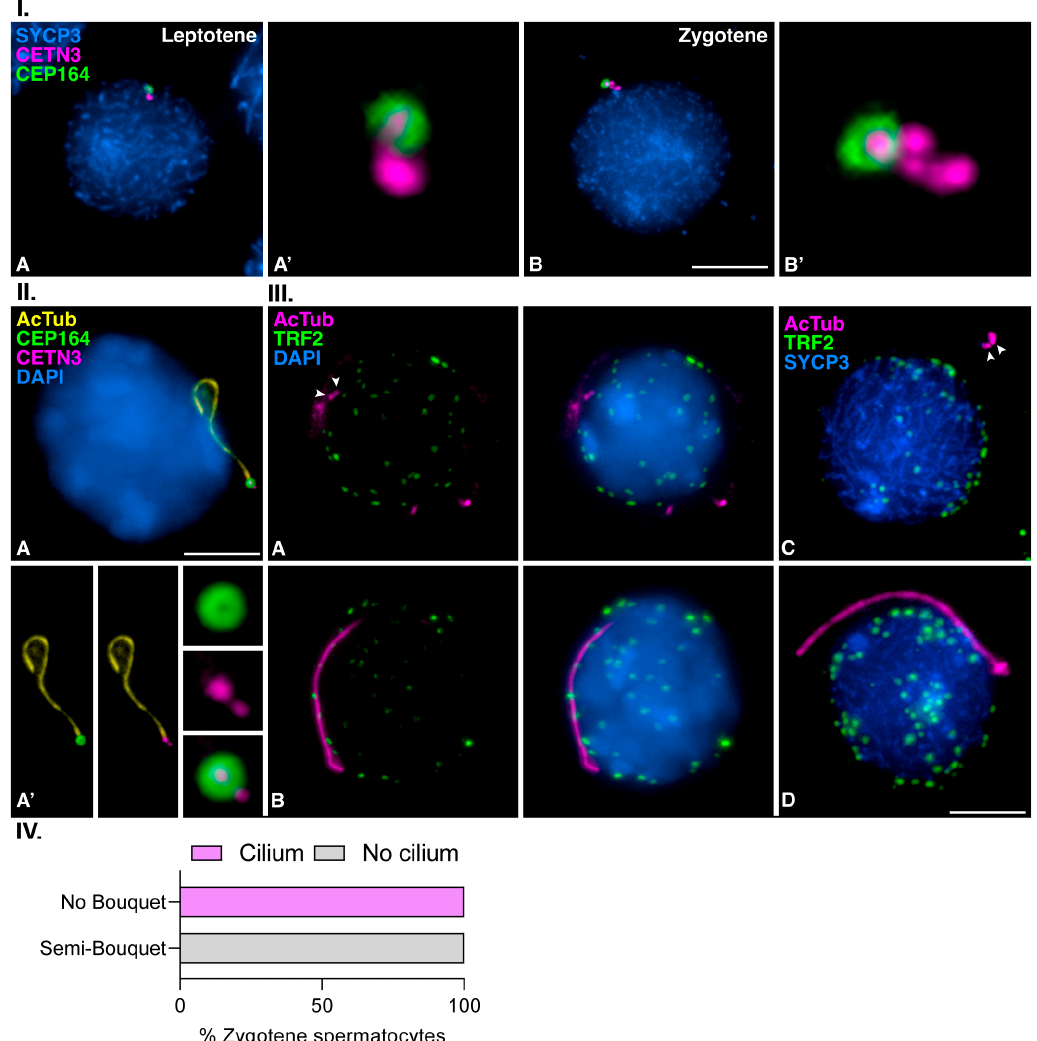
Figure 6. Mouse meiotic cilia emanate from the mother centriole before centrosome duplication. ( I ) . Distribution of CEP164 in early prophase I spermatocytes; Triple immunolabelling of SYCP3 (blue), Centrin 3 (CETN3) (magenta), and CEP164 (green) in mouse spermatocytes at ( A ) Leptotene, and ( B ) Zygotene. Images ( A (cid:48) , B (cid:48) ) show the 300 × magnification of the centrosomes. Scale bar in B represents 5 µ m. ( II ) . Meiotic zygotene cilia emanate from the unduplicated mother centriole; Triple immunolabelling of acetylated Tubulin (AcTub) (yellow), CEP164 (green), and Centrin 3 (CETN3) (magenta), with chromatin stained with DAPI (blue) on squashed WT mouse sperma- tocytes at ( A ) Zygotene presenting a primary cilium. Images in ( A (cid:48) ) show the primary cilia and the 300 × magnification of the centrosomes. Scale bar in A represents 5 µ m. ( III ) . The presence of the primary cilia is not directly related to the bouquet conformation of chromosome ends; Dou- ble immunolabelling of acetylated Tubulin (AcTub) (magenta) and TRF2 (green), with chromatin stained with DAPI (blue) on squashed WT mouse spermatocytes at ( A ) Zygotene without cilium, and ( B ) ciliated Zygotene. Triple immunolabelling of acetylated tubulin (AcTub) (magenta) and TRF2 (green) and SYCP3 (blue) on squashed WT mouse spermatocytes at ( C ) Zygotene without cilium and ( D ) Zygotene with cilium. White arrowheads in ( C , D ) indicate centrosomes localization. Scale bar in ( D ) represents 5 µ m. ( IV ) . There is no direct relation nor concurrency between the presence of meiotic cilia and the representative mouse bouquet configuration; Graphical representation of the quantification of ciliated spermatocytes at Zygotene ( n = 50, three biological replicates) that present a semi- bouquet